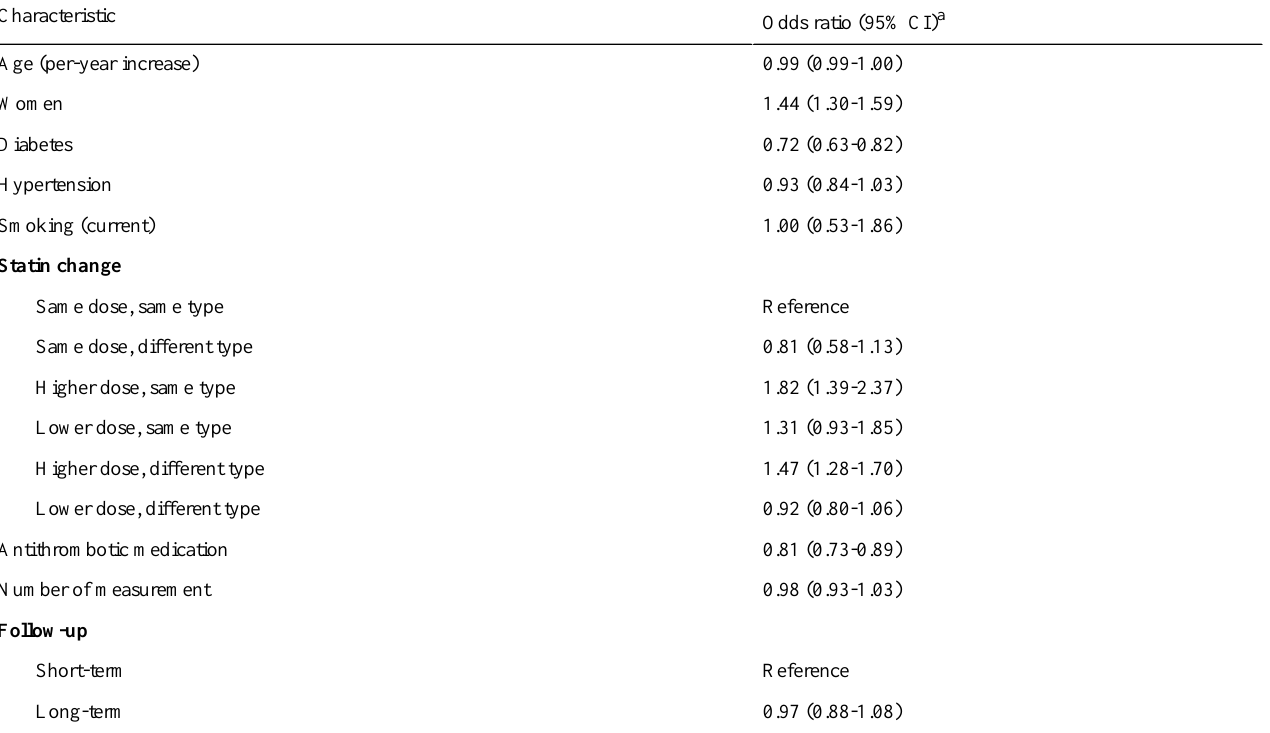
Table 4. Logistic regression associations with deterioration of low-density lipoprotein cholesterol